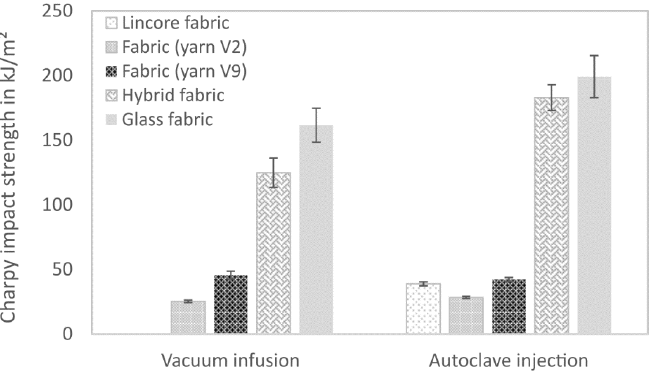
Figure 14. Unnotched Charpy impact strength of composites produced by vacuum infusion and autoclave injection. Results are shown as mean values with standard deviation as error bars.